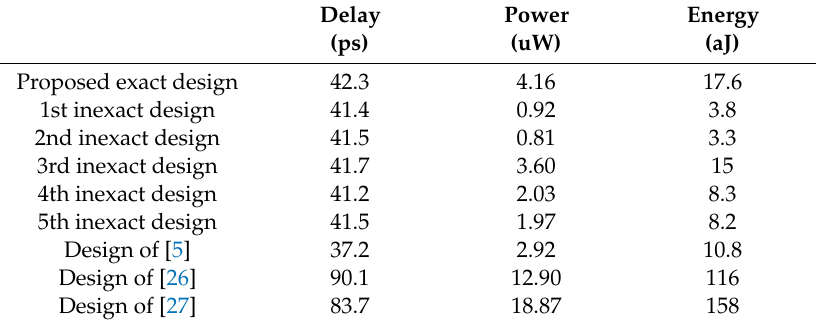
Table 5. Simulation Results.